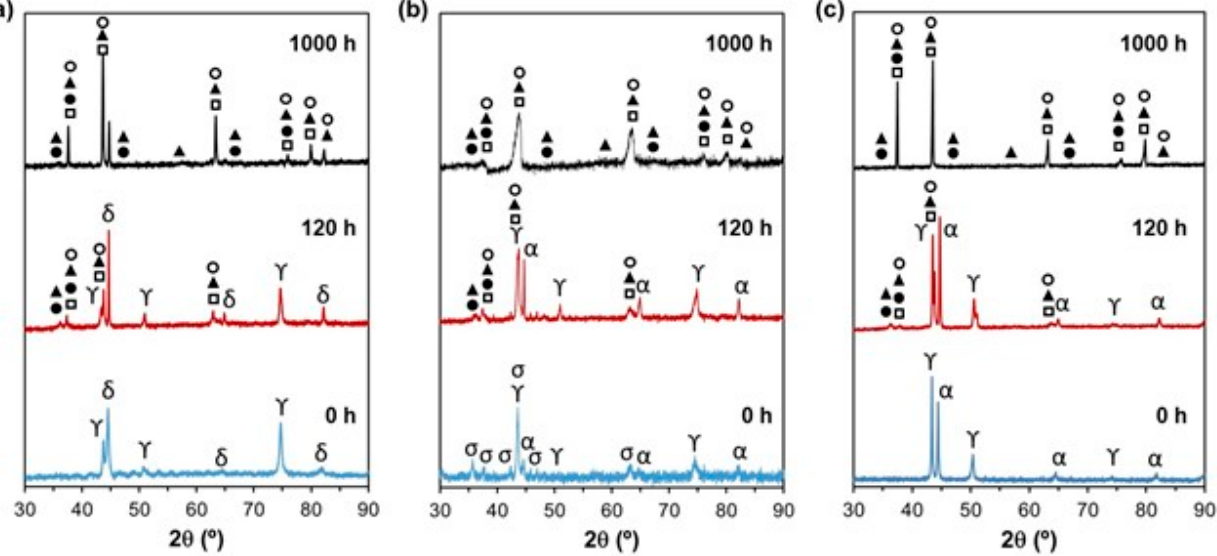
Figure 2. XRD spectra and peak identification chart of oxide scales formed on the surfaces of ( a ) SS301, ( b ) DS2205 and ( c ) DS2507 after several exposure times to molten salts. The symbols denote the phases: α , δ , γ and σ (of metallic substrate); ○ α -LiFeO 2 (JCPDS file cards no. 74-2284); ▲ LiCrO 2 (JCPDS 24-0600); ● FeCr 2 O 4 (JCPDS 34-0140); and □ NiO (JCPDS 47-1049).